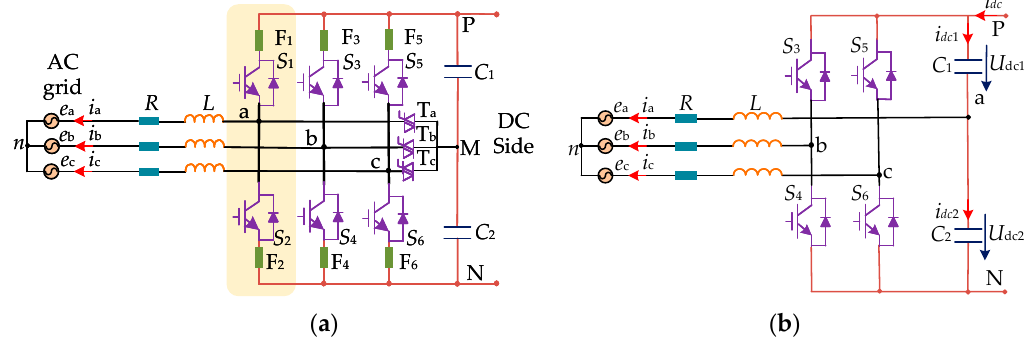
Figure 1. The fault-tolerant topology of BVSC. ( a ) Nonredundant fault-tolerant structure; ( b ) three- phase four-switch (TPFS) structure with leg fault of phase